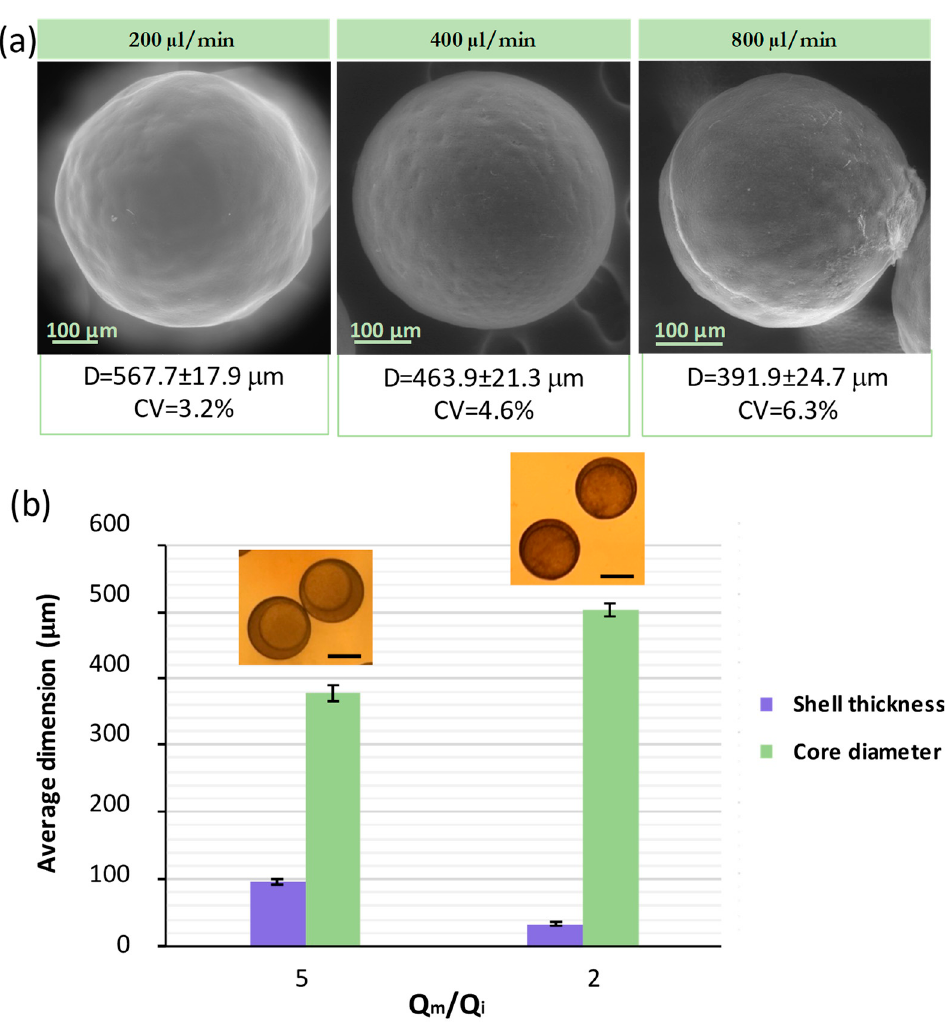
Figure 5. ( a ) SEM image of Trojan microparticles produced by altering the continuous phase flow rate (Qo) from 200 to − 800 μ L/min and leaving constant the internal (Qi, 5 μ L/min) and middle flow rates (Qm, 10 μ L/min). Mean size and coefficient of variation (CV). ( b ) Effect of Qm/Qi ratio when Qo (200 μ L/min) and middle flow Qm (10 μ L/min) were kept constant. Shell and core diameters were measured from optical images such as the ones depicted in the insets.